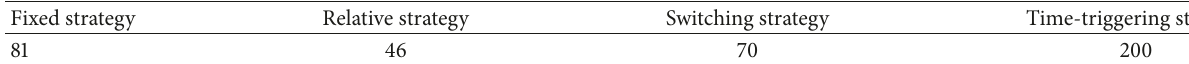
Table 1: Times of triggering events.